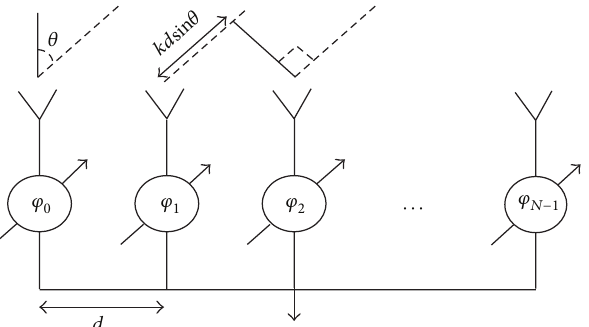
Figure 2: Uniform linear array having 𝑁 elements, precalculated set of 𝜑 𝑛 to spoil beams, interelement distance 𝑑 , wave number 𝑘 , and target direction 𝜃